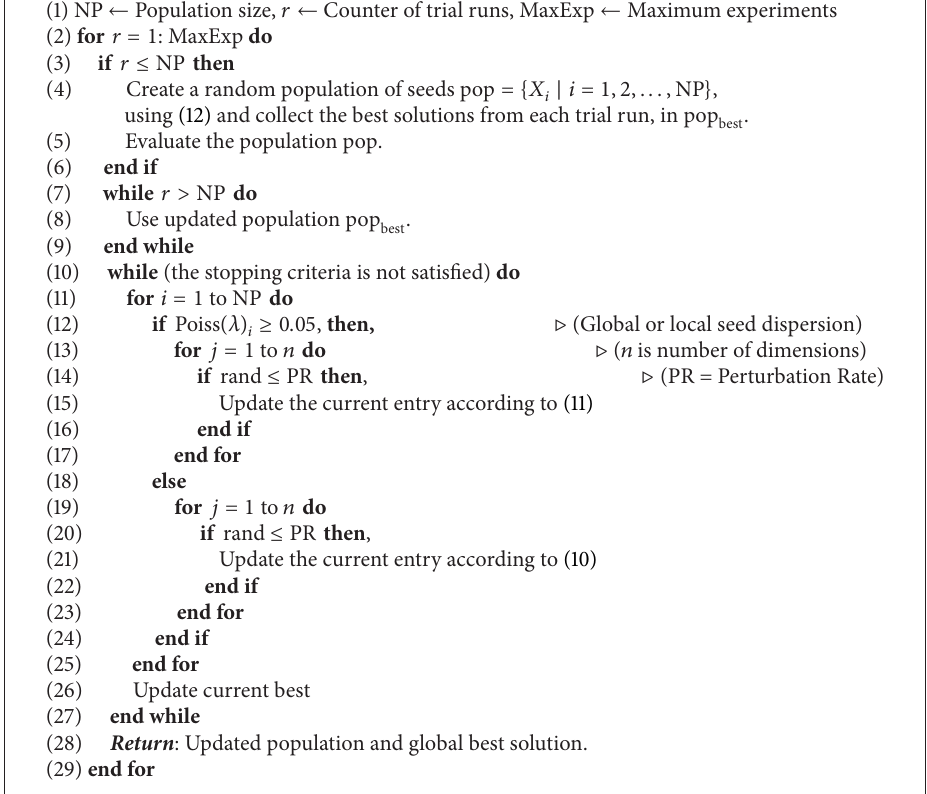
Algorithm 1: Seed-based Plant Propagation Algorithm (SbPPA)